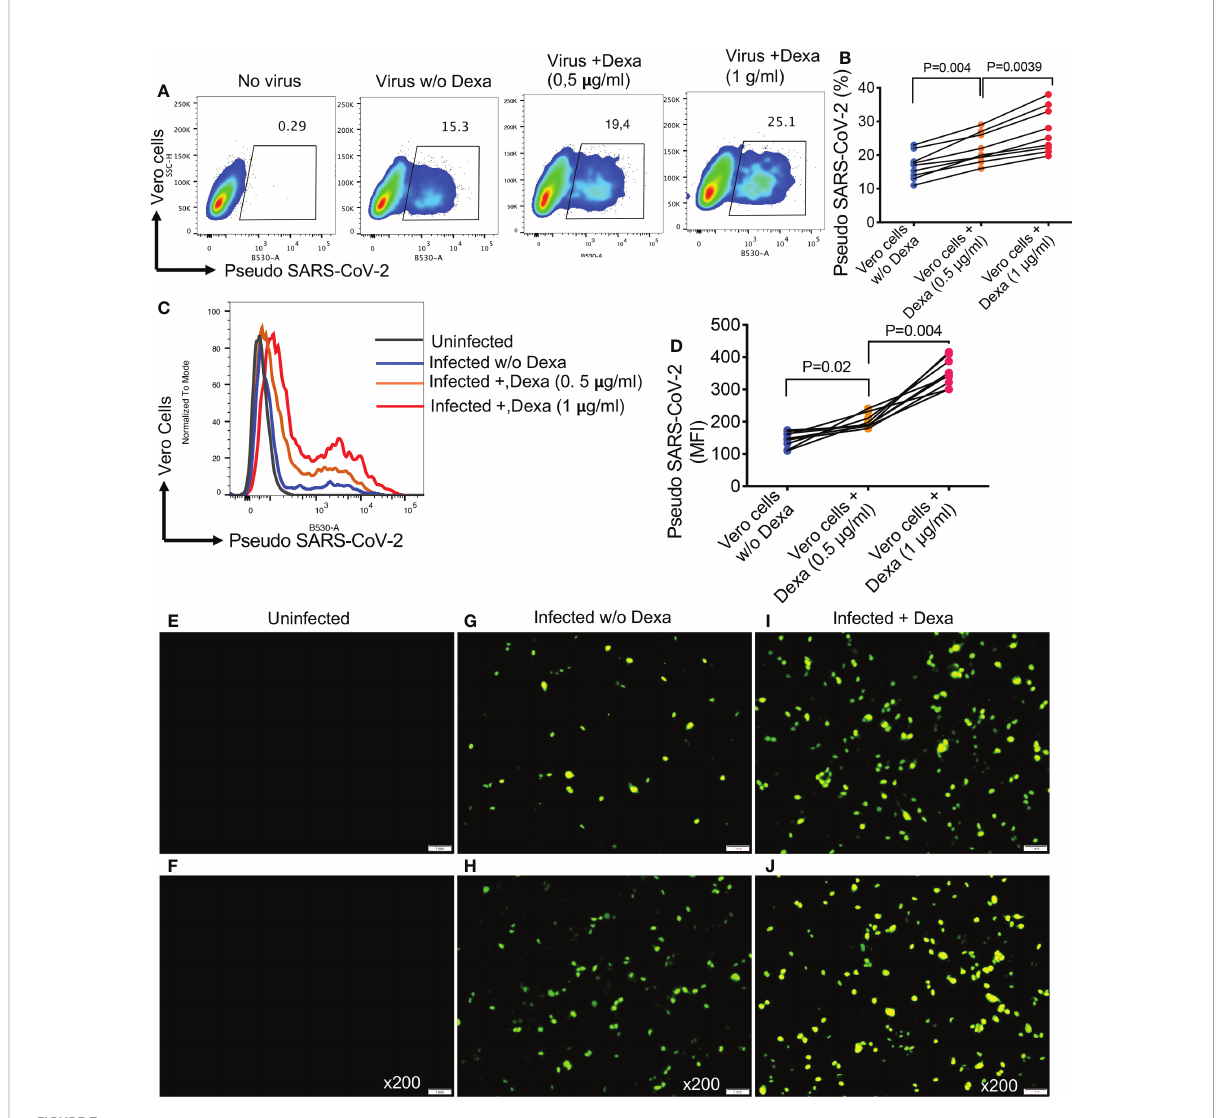
FIGURE 7 Dexamethasone treatment enhances the infectivity of Vero E6 cells to Pseudo SARS-CoV-2 infection. (A) Representative fl ow cytometry plots, and (B) cumulative data showing percentages of Vero E6 cells untreated or treated with dexamethasone (0.5 m g/ml and 1 m g/ml) and infected with the pseudo SARS-CoV-2. (C) Representative fl ow cytometry histogram plots, and (D) cumulative data showing the MFI of pseudo SARS- CoV-2 infection in Vero E6 cells untreated or treated with dexamethasone (0.5 m g/ml and 1 m g/ml). (E, F) Representative images of uninfected Vero E6 cells. (G, H) Representative images of dexamethasone untreated but infected Vero E6 cells with pseudo SARS-CoV-2. (I, J) Representative images of dexamethasone treated and infected Vero E6 cells with pseudo SARS-CoV-2, magni fi cation x200. Error bars indicate mean ± SEM from at least two independent experiments. Each dot represents results from a single experiment. Dexamethasone (Dexa), Vero E6 cells (Vero cells), virus (pseudo